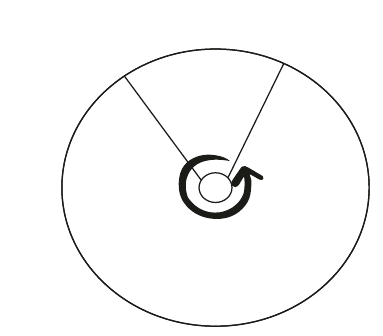
Figure 7: An example of RADAR routing